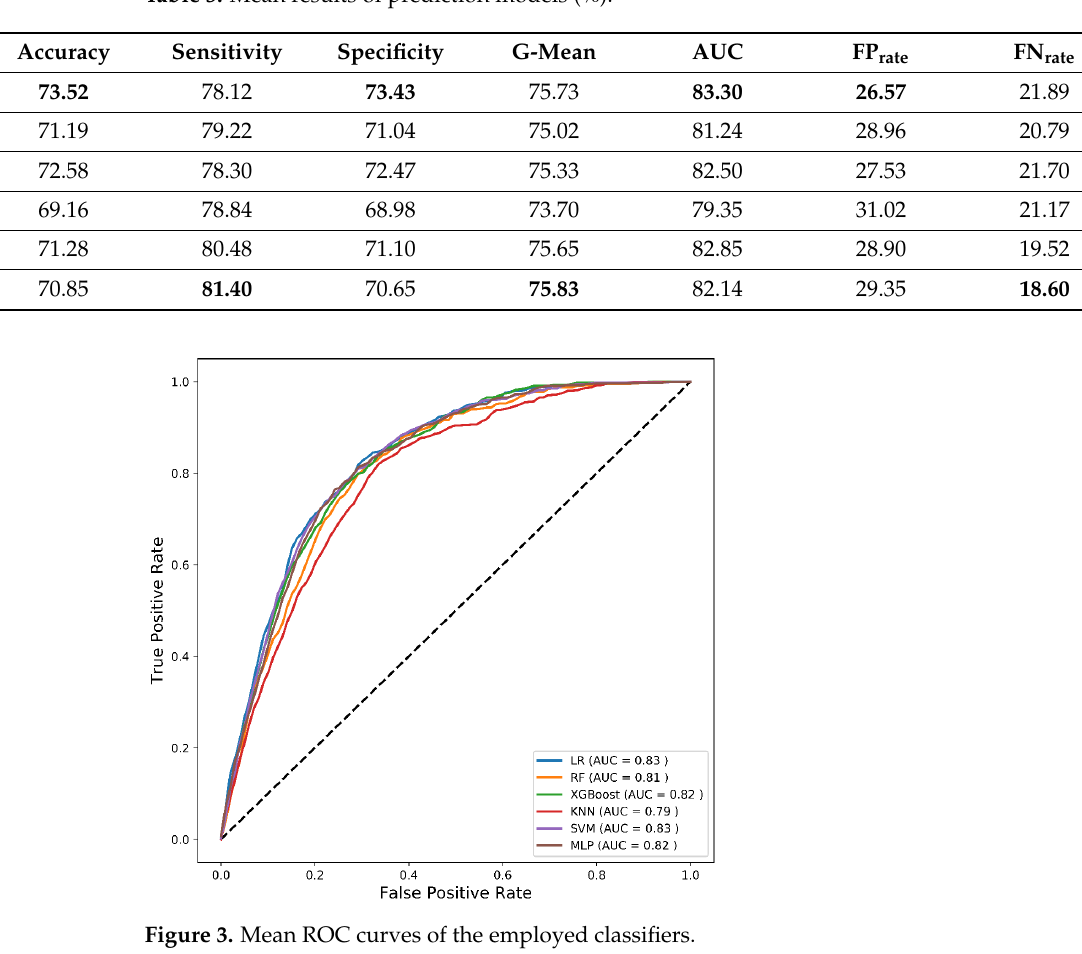
( b ) Figure 5. Risk factors’ impact on MLP model output for the cerebral stroke prediction dataset. ( a ) The distribution of the impact of a risk factor value on the model output across test instances. ( b ) The average impact magnitude for test instances. Partial dependence plots were also generated (Figure 6) to quantify the marginal ef- fect of the three most important risk factors on the predicted output of the MLP model. These plots demonstrate the kind of relationship between the occurrence of a stroke and the risk factors (e.g., monotonic, linear, or more complex). Figure 6a depicts a linear and positive relationship between age and the occurrence of stroke. A linear but negative